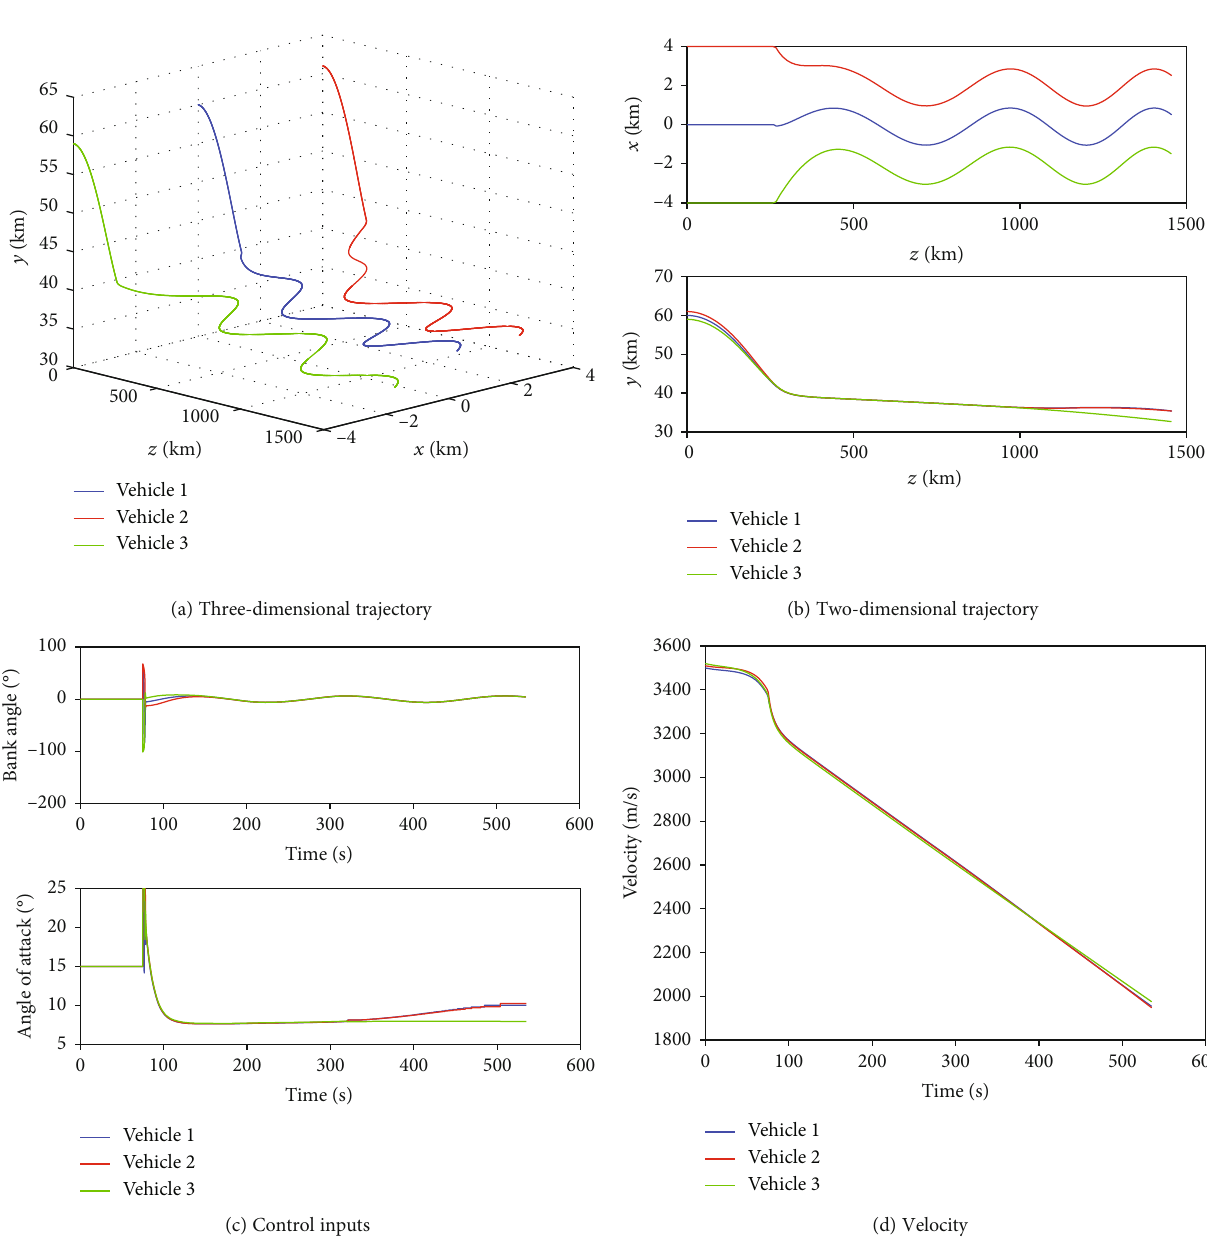
Figure 6: Simulation results of lateral maneuver.